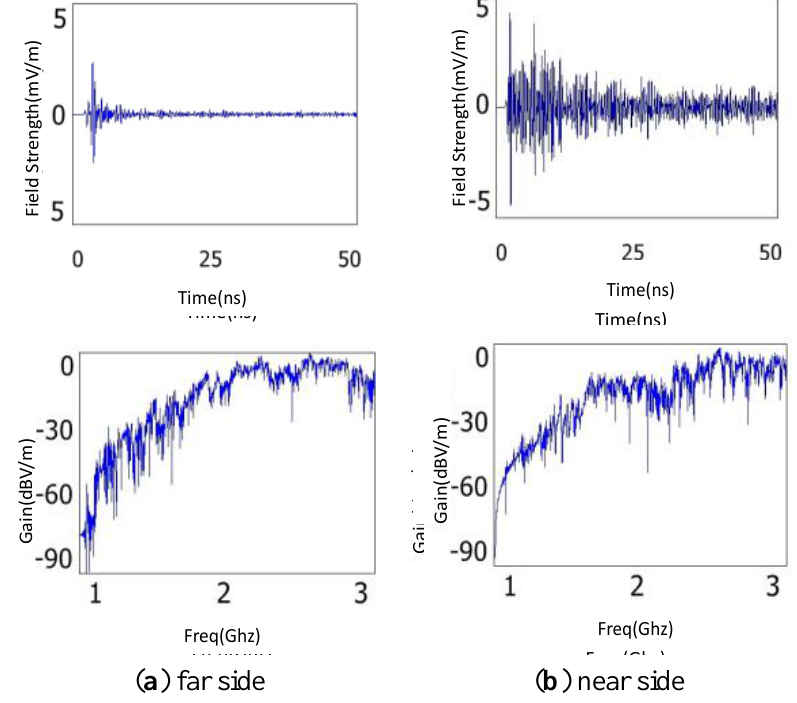
Figure 11. Simulation results of the influence of CT on the propagation of EM waves.